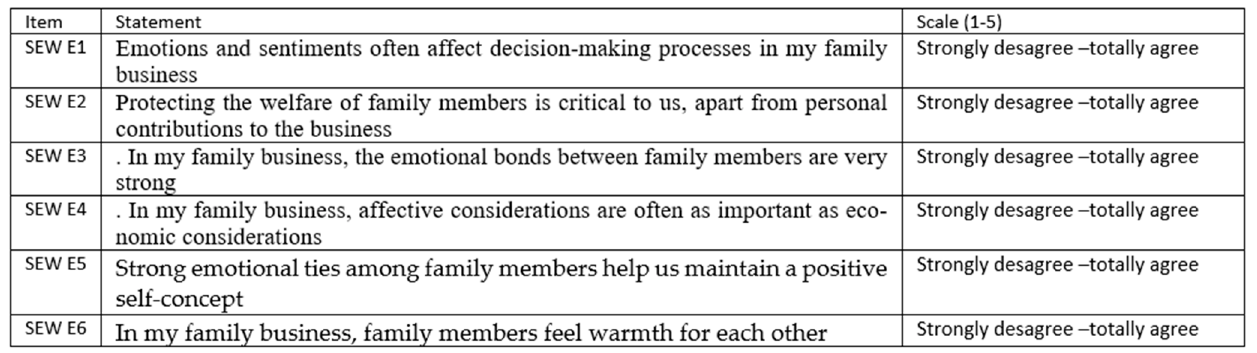
Figure 2. Statements and scales used for the measurable items that represent SEW dimension E. Source: [54].